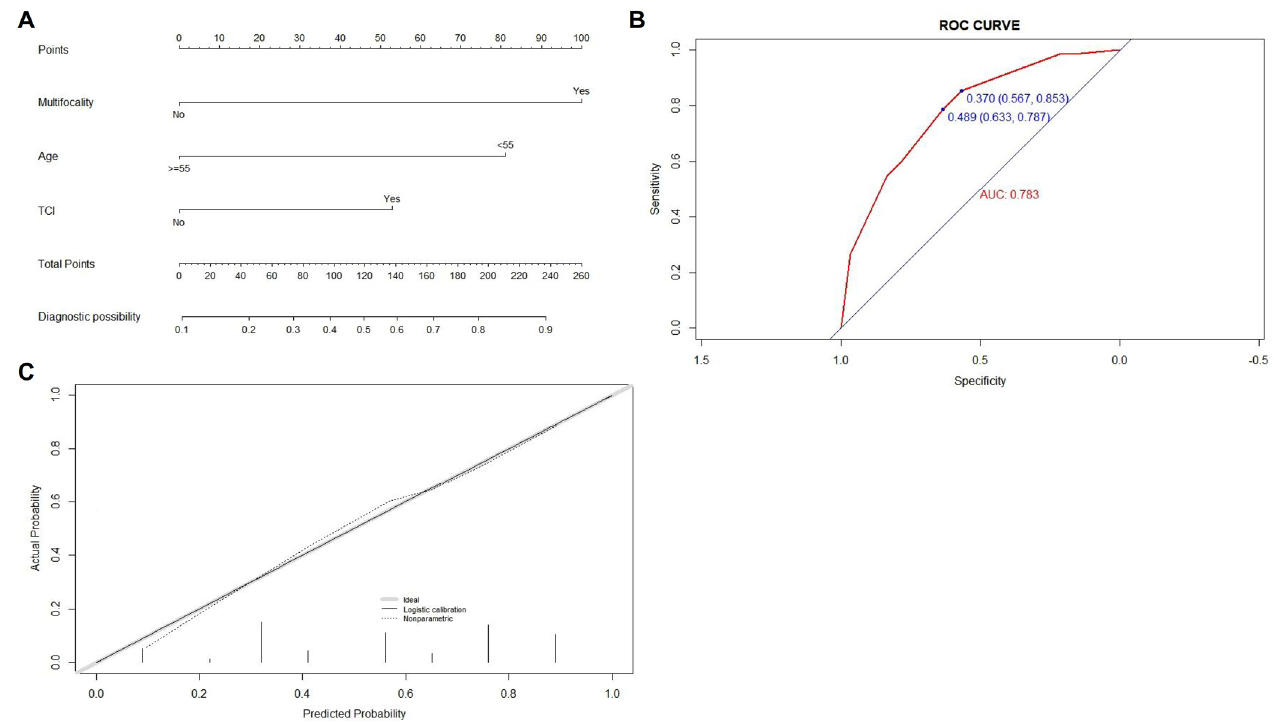
Figure 2. Construction, assessment, and validation of the predictive model of CLNM for PTMC patients within the Bil group. ( A ) The nomograms for predicting CLNM risk in PTMC patients within the Bil group; ( B ) the ROC curve and AUC of the nomogram for predicting CLNM risk in PTMC patients within the Bil group; ( C ) the calibration curve of the nomogram for predicting CLNM risk in PTMC patients within the Bil group. Actual probability is plotted on the y-axis, and nomogram predicted probability on the x-axis. PTMC, papillary thyroid microcarcinoma; CLNM, central lymph node metastasis; TCI, thyroid capsular invasion; ROC, receiver operating characteristics.